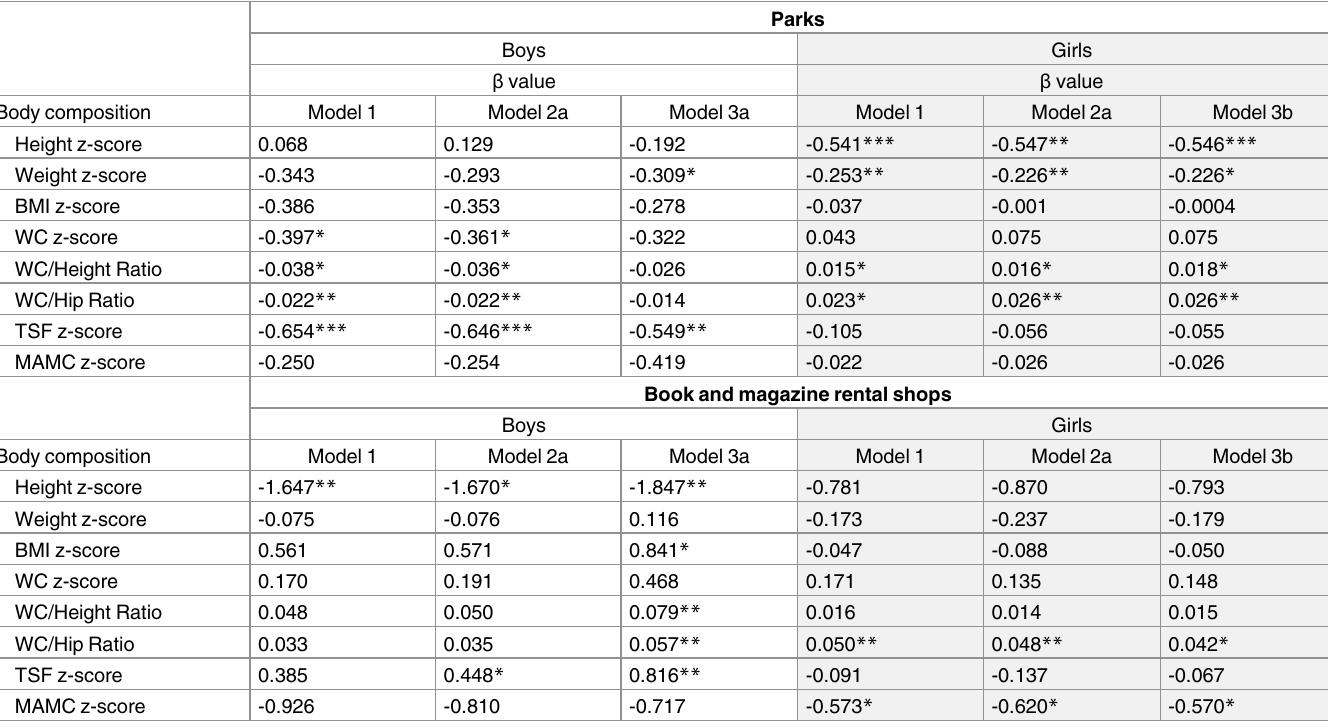
Table 6. Multiple linear regression for the body composition in relation to parks and book and magazine rental shops within 1000m a around junior high school without FS, CS and BS <